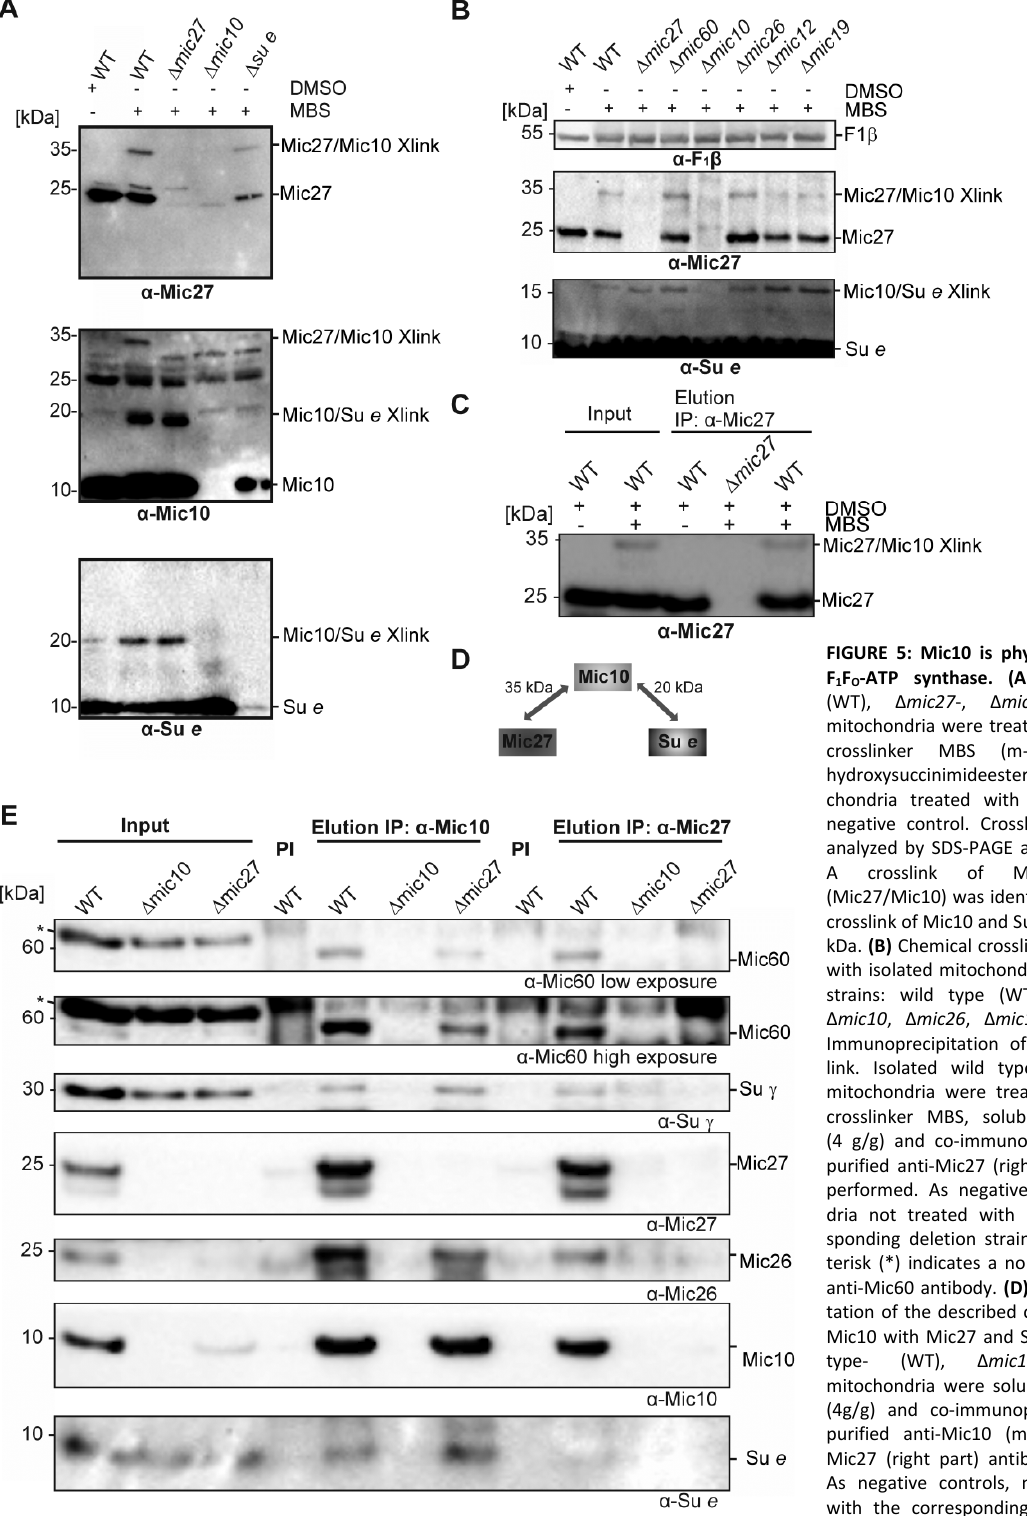
FIGURE 5: Mic10 is physically linked to the F 1 F O -ATP synthase. (A) Isolated wildtype- (WT), Δ mic27 -, Δ mic10 - and Δ su e - mitochondria were treated with the chemical crosslinker MBS (m-maleimidobenzoyl-N- hydroxysuccinimideester). Wild type mito- chondria treated with DMSO served as a negative control. Crosslinked proteins were analyzed by SDS-PAGE and Western blotting. A crosslink of Mic27 and Mic10 (Mic27/Mic10) was identified at 35 kDa and a crosslink of Mic10 and Su e (Mic10/Su e) at 20 kDa. (B) Chemical crosslinking was performed with isolated mitochondria of indicated yeast strains: wild type (WT), Δ mic27 , Δ mic60 , Δ mic10 , Δ mic26 , Δ mic12 and Δ mic19 . (C) Immunoprecipitation of Mic27-Mic10 cross- link. Isolated wild type- (WT) or Δ mic27 - mitochondria were treated or not with the crosslinker MBS, solubilized with digitonin (4 g/g) and co-immunoprecipitation using a purified anti-Mic27 (right part) antibody was performed. As negative controls, mitochon- dria not treated with MBS and the corre- sponding deletion strain were used. The as- terisk (*) indicates a nonspecific band of the anti-Mic60 antibody. (D) Schematic represen- tation of the described chemical crosslinks of Mic10 with Mic27 and Su e. (E) Isolated wild type- (WT), Δ mic10 - and Δ mic27 - mitochondria were solubilized with digitonin (4g/g) and co-immunoprecipitation using a purified anti-Mic10 (middle part) or anti- Mic27 (right part) antibody was performed. As negative controls, mitochondria treated with the corresponding pre-immune serum (PI) and the corresponding deletion strains were used. The asterisk (*) indicates a non- specific band of the anti-Mic60